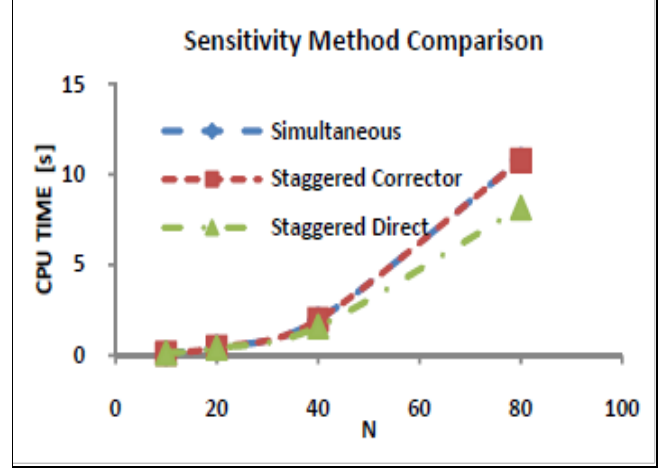
Figure 4: Comparison of the CPU time for the numerical sensitivity